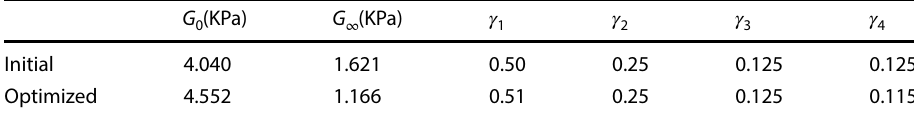
Table 1 Shear response variation on optimization